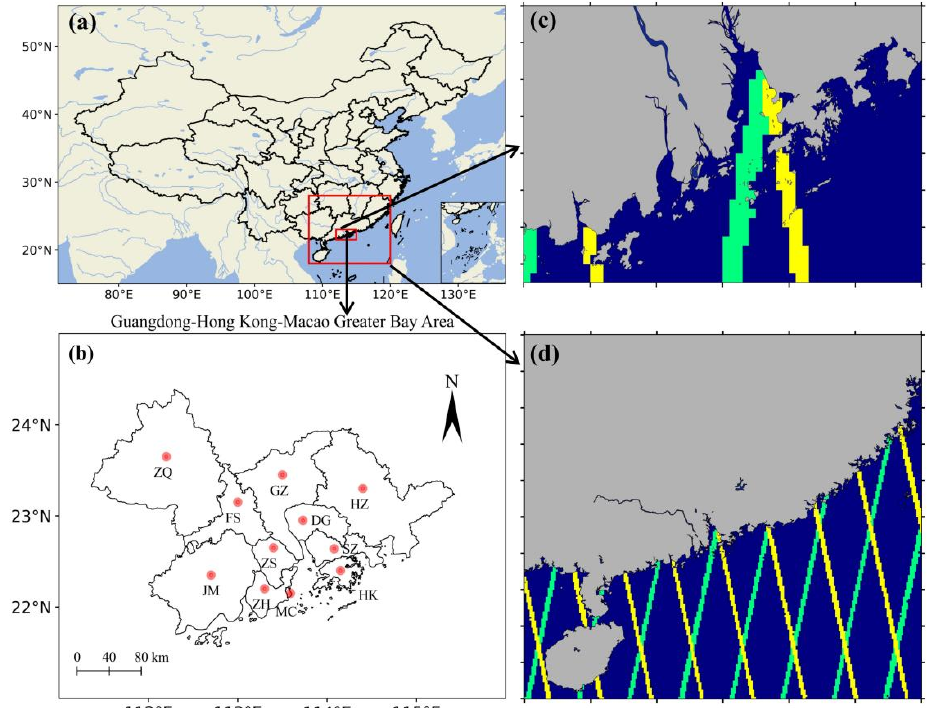
Figure 1. ( a ) Map of the study areas of coastal waters of the GBA and the NSCS, which are the sea areas in the small red frame (longitude: 112°–115°E; latitude: 21.5°–23°N) and in the large red frame (longitude: 108°–120°E; latitude: 18°–28°N), respectively; ( b ) cities of the GBA; ( c , d ) the CALIOP tracks in the two study areas of coastal waters of the GBA and the NSCS (yellow and green lines correspond to day and night tracks, respectively).